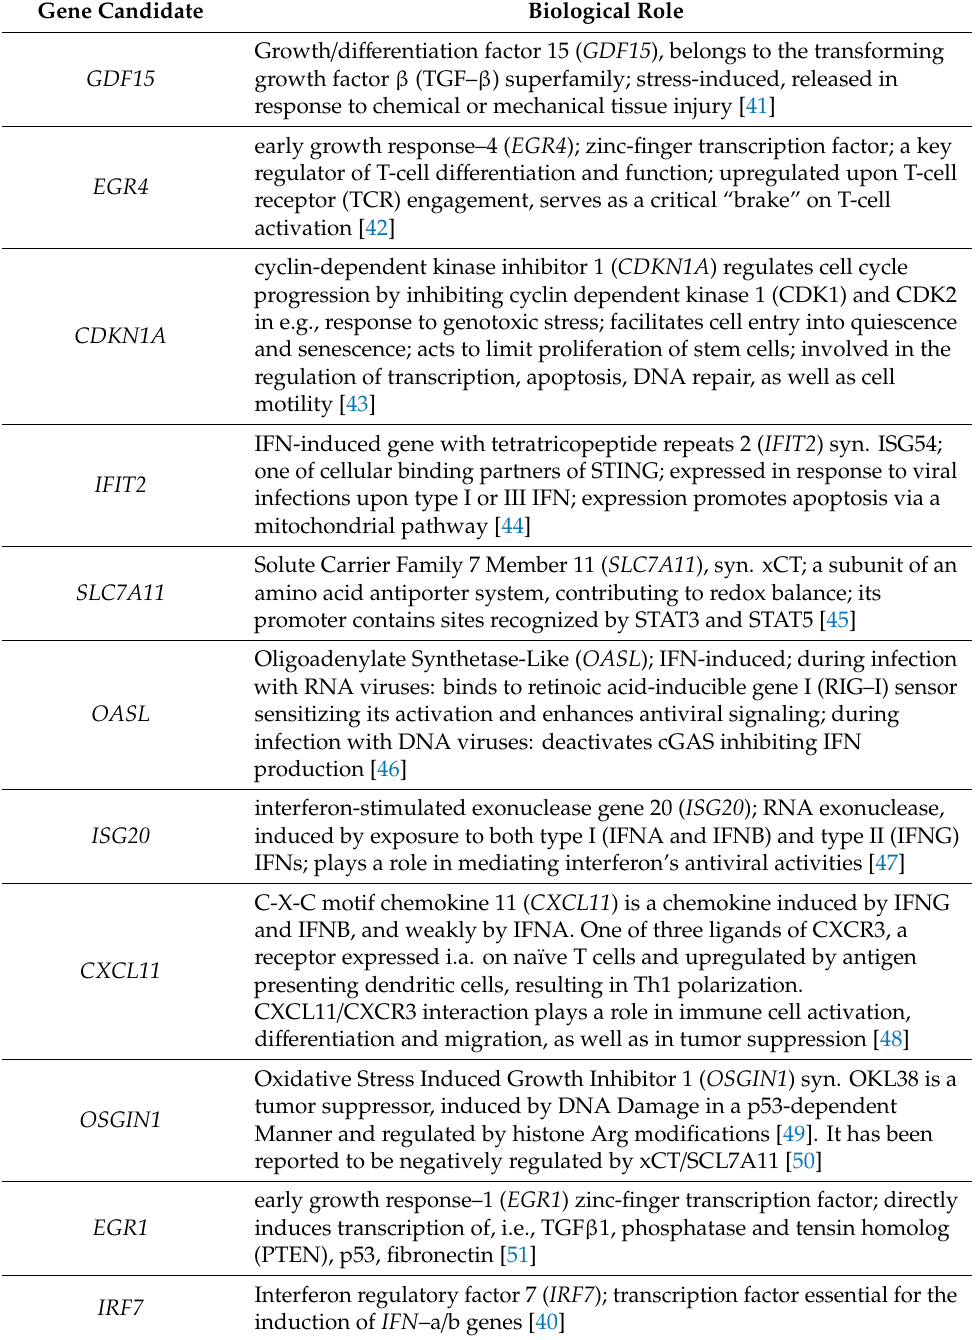
Table 2. Biological Roles of Genes Selected for RT-qPCR